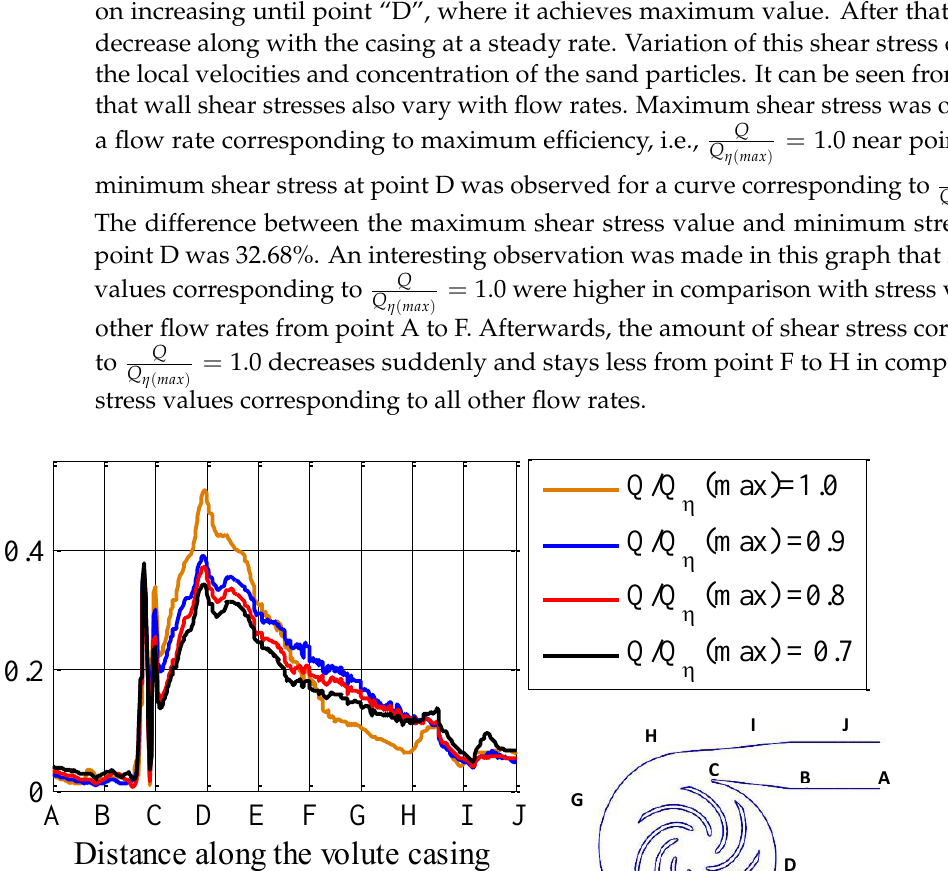
Figure 11. Characteristic curves of the centrifugal pump.